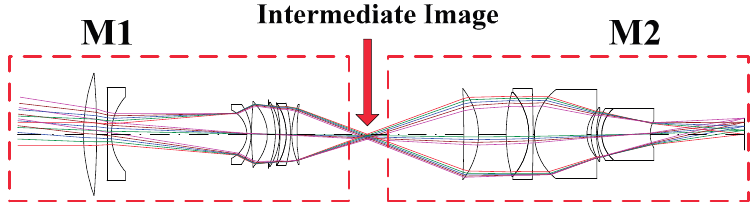
Figure 1. The illustration of zoom ratio with relay image (M1 is first group of zoom lens and M2 is second group of zoom